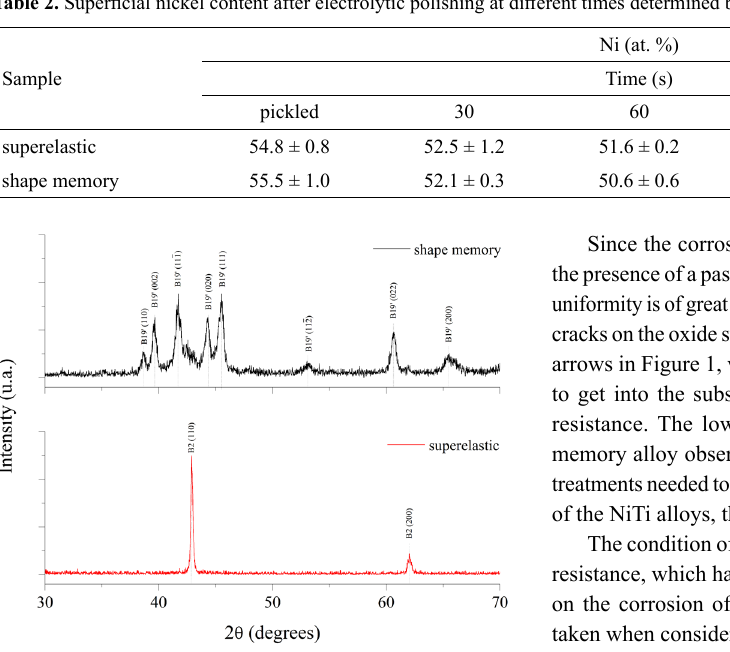
Figure 5. X-ray diffraction profile of superelastic and shape memory NiTi alloys after 240 s of electrolytic polishing.